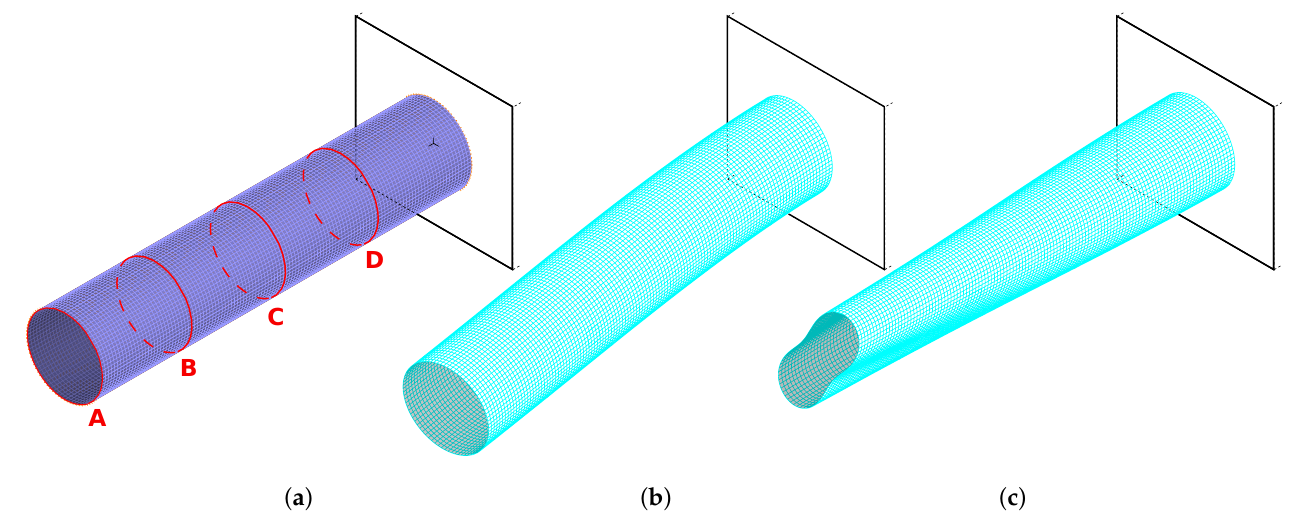
Figure 1. The finite element (FE) model ( a ) and two examples of vibration mode shapes: ( b ) B11, ( c ) C21.